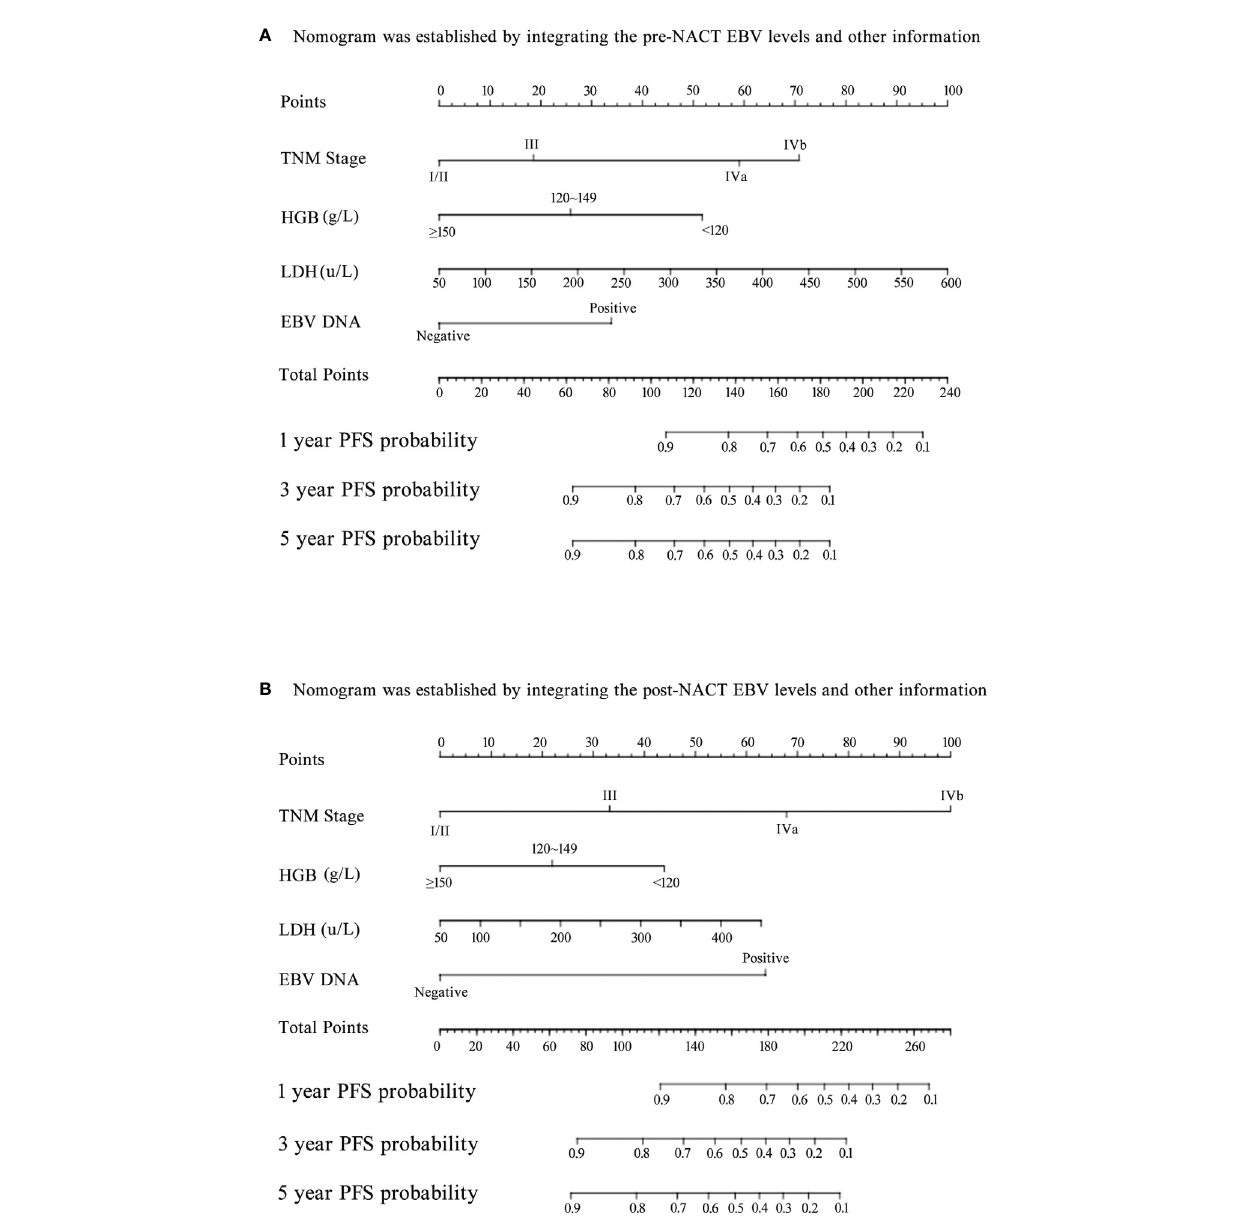
FIGURE 4 | Nomogramforpredictingthe1-year,3-year,and5-yearprogression-freesurvival(PFS)ofpatients. (A) ThenomogramwasestablishedbyintegratingtheTNMstage, HGB,LDH,andpre-neoadjuvantchemotherapy(NACT)EBVlevels; (B)